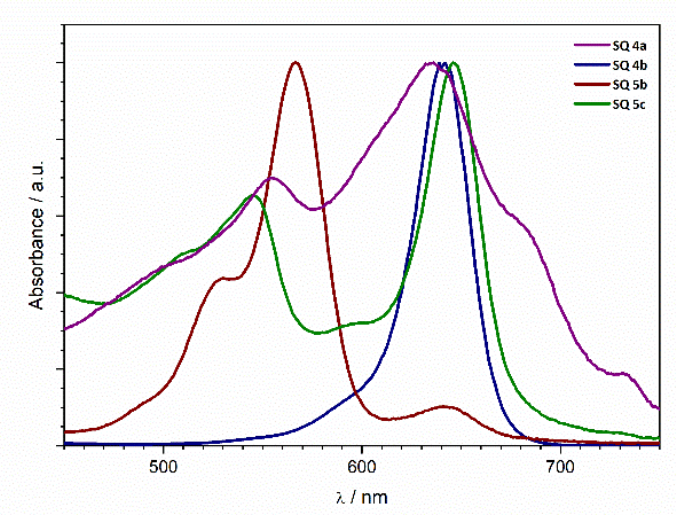
Figure 7. Normalized absorption spectra of compounds 1a – 1c (in ethyl alcohol).